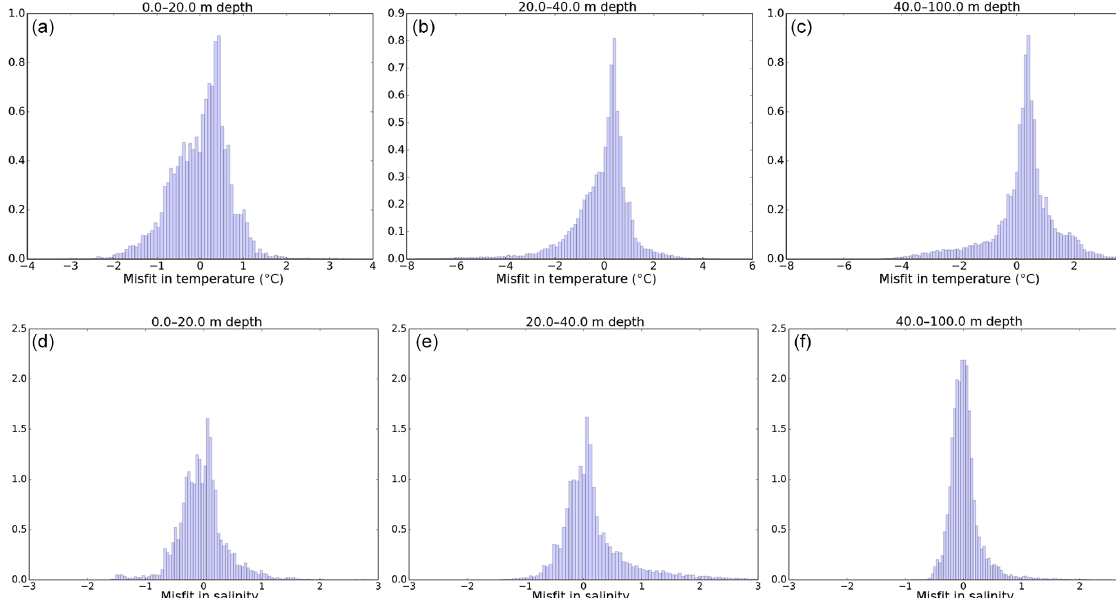
Figure 5. Normalized distribution of the misfit (modelled–observed) in temperature (a, b, c) and salinity (d, e, f) from RECOPESCA and Argo in situ profiles (only for profiles deeper than 100m) for three vertical layers: 0–20m depth (a, d) , 20–40m depth (b, e) and 40–100m depth (c, f) . The integral of the histogram sums up to